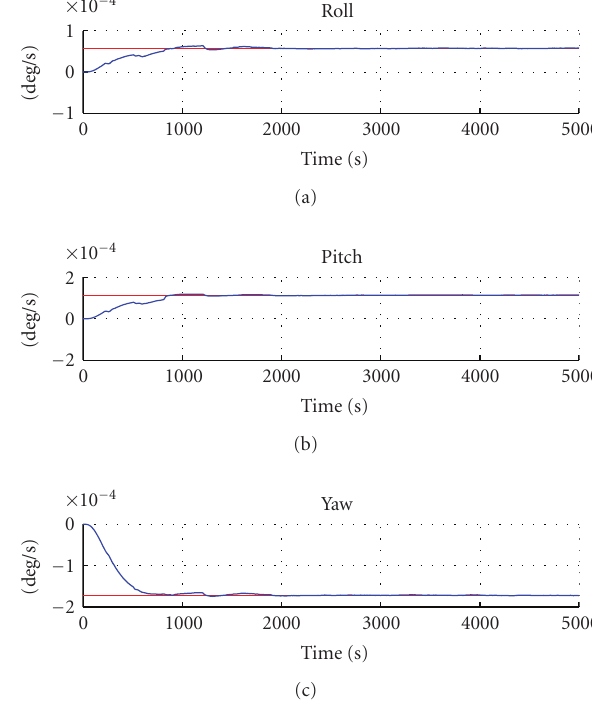
Figure 11: Gyro bias